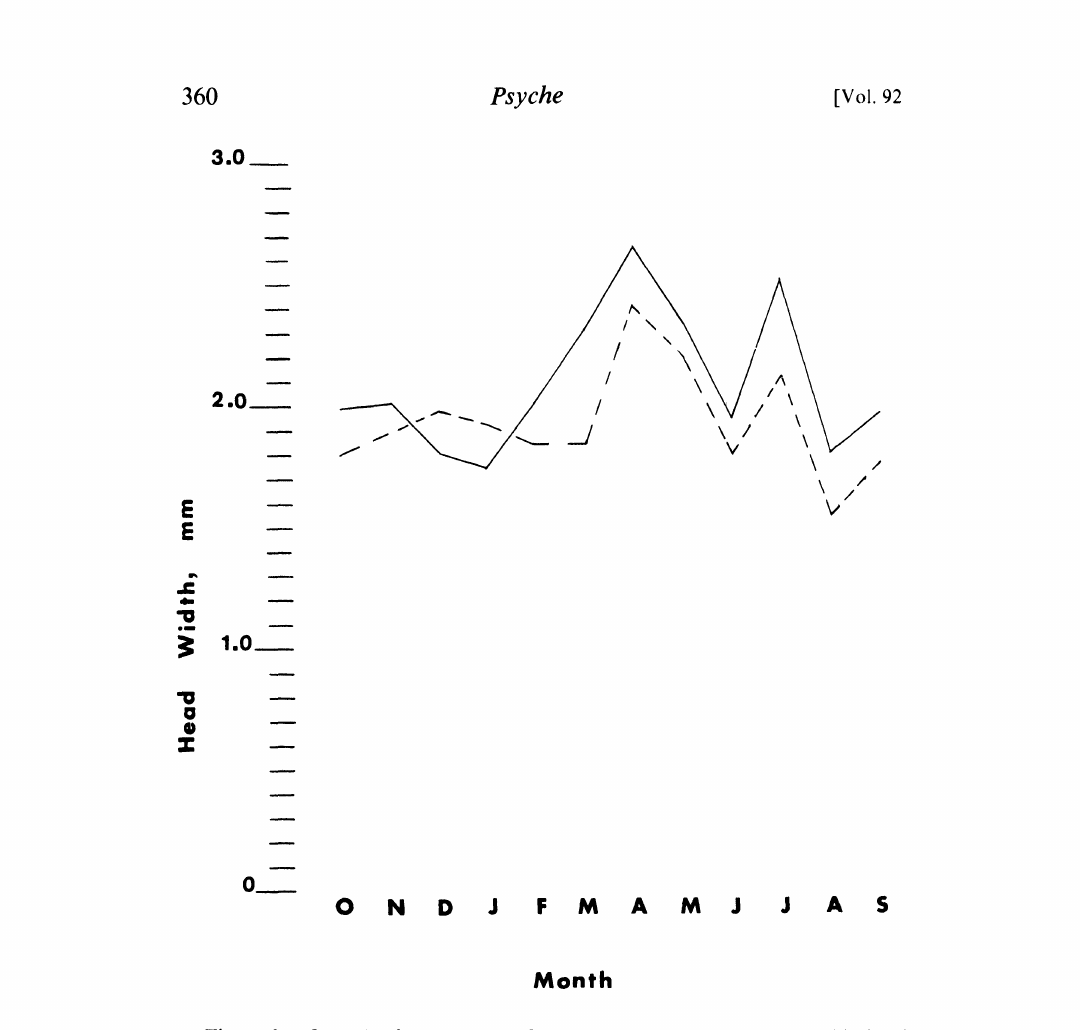
Figure 2. Growth of Baetisca carolina nymphs based on mean monthly head widths. Solid line represents female growth; broken line represents male